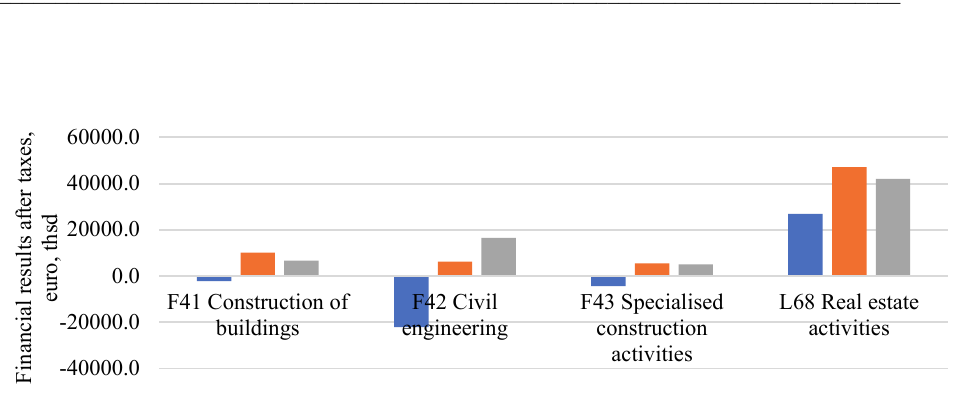
Fig. 7. Financial results after taxes of non-financial merchants by economic activity (NACE Rev.2) and time period from 2021Q1 to 2021Q3 in Latvia (profit or losses, euro, thsd) (developed by the authors based on European Statistics Database